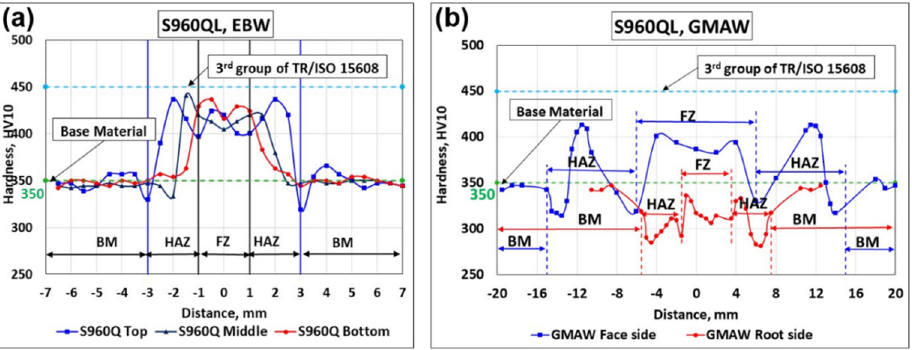
Figure 7. The macro hardness distribution. ( a ) Macro hardness graph, EBW; ( b ) Macro hardness graph, GMAW data from [26].